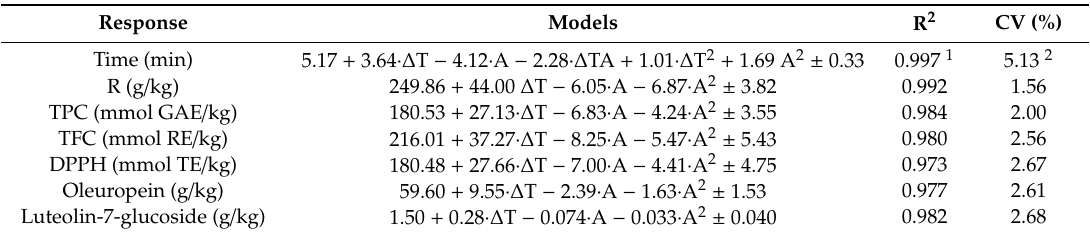
Table 3. Mathematical models displayed in coded factors describing the behavior of the responses, including the main statistical